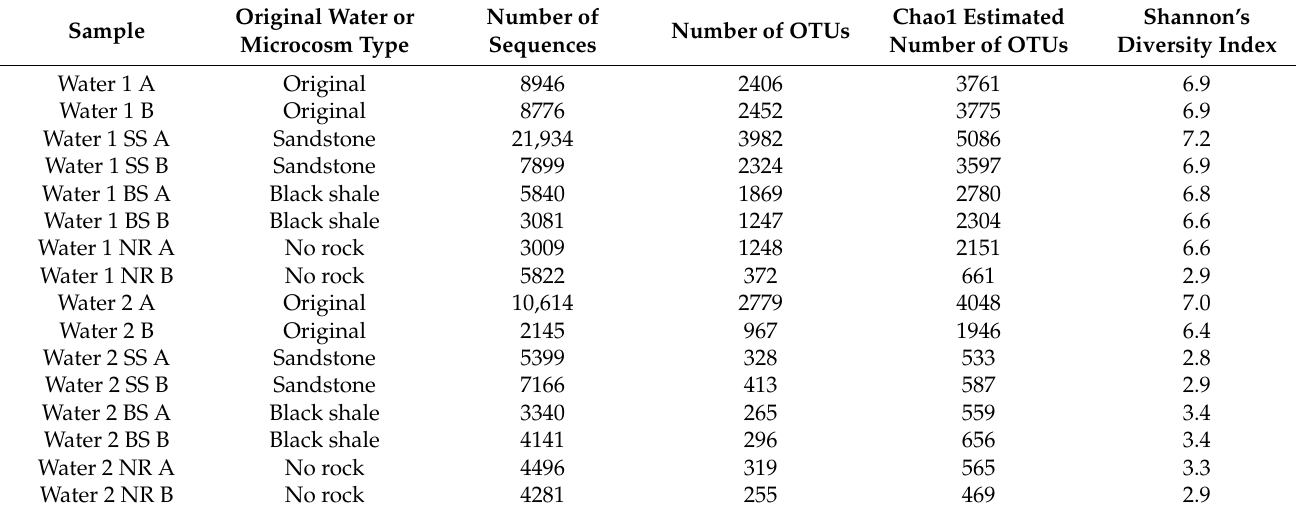
Table 3. Sequence data information and